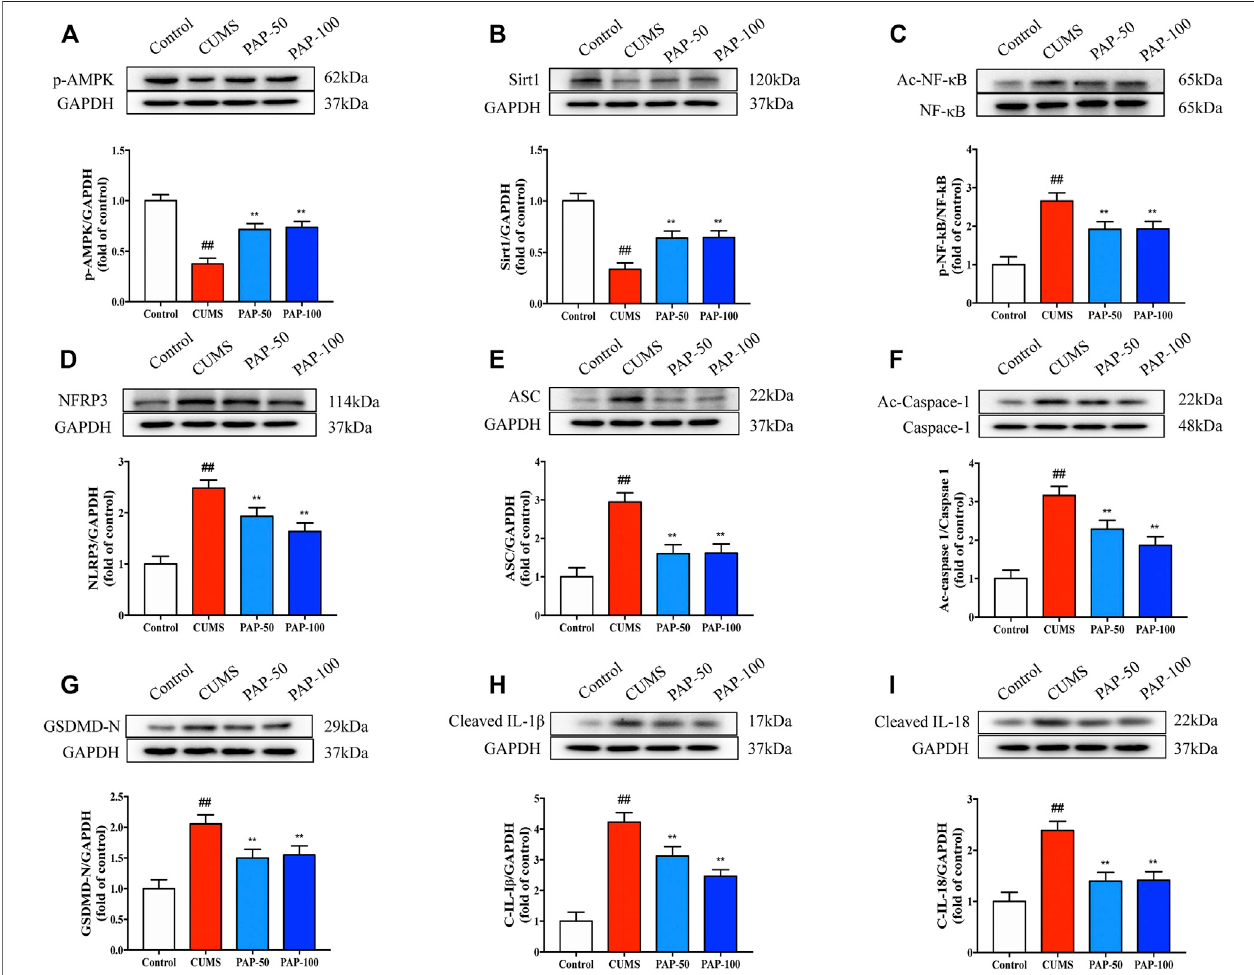
FIGURE 3 | Effect of PAP on the AMPK/Sirt1/NF- κ B/NLRP3 pathway. The protein expressions of p-AMPK (A) , Sirt1 (B) , Ac-NF- κ B (C) , NLRP3 (D) , ASC (E) , Ac- Caspase-1 (F) , GSDMD-N (G) , Cleaved-IL-1 β (H) , and Cleaved-IL-18 (I) in hippocampal tissues. ## p < 0.01 vs. control group, * p < 0.05, and ** p < 0.01 vs. CUMS